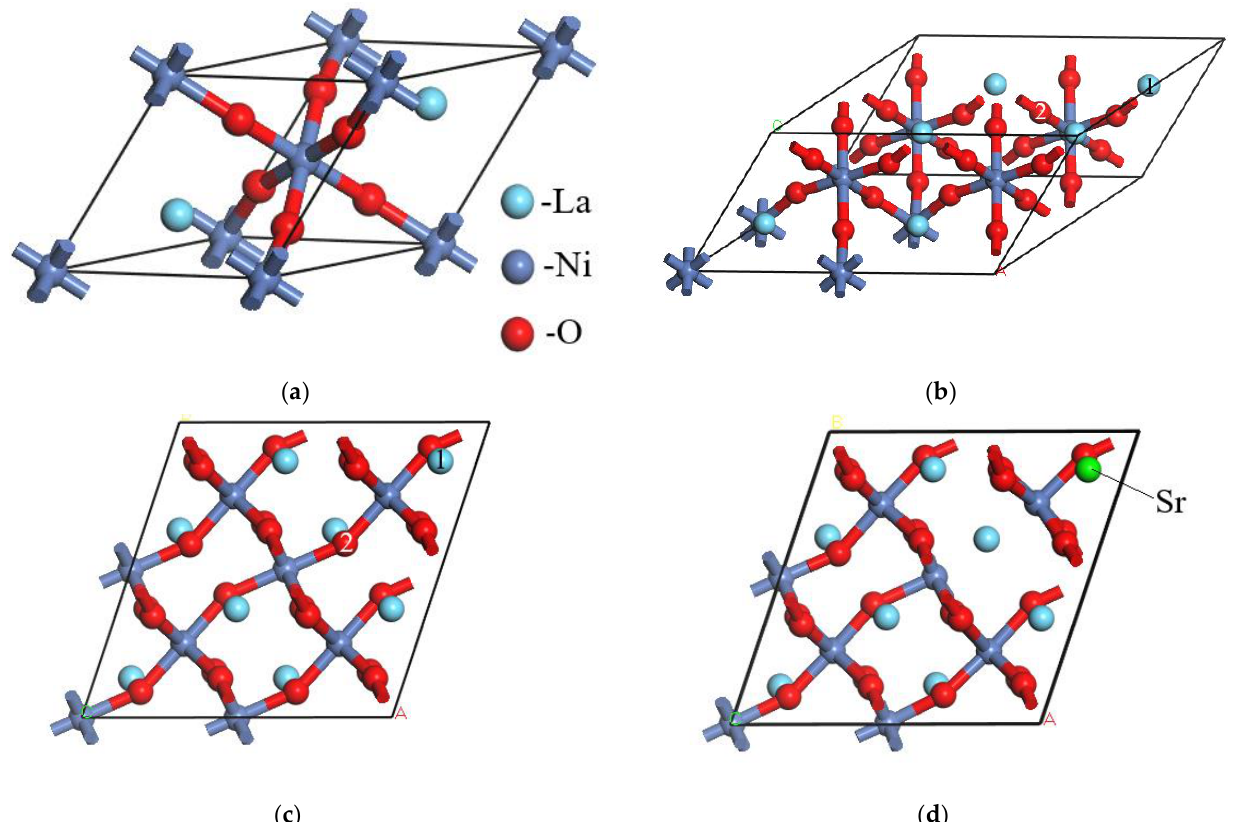
Figure 8. ( a ) LaNiO 3 primitive unit cell; ( b ) LaNiO 3 2 × 2 × 1 supercell; ( c ) LaNiO 3 2 × 2 × 1 supercell top view; ( d ) La 0.875 Sr 0.125 NiO 3−σ 2 × 2 × 1 supercell top view; 1: substitution position, 2: oxygen vacancy position.